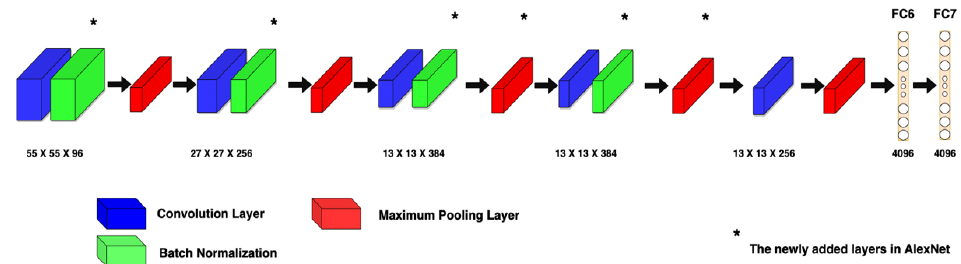
Figure 4. Mod_AlexNet: modified AlexNet architecture (4 batch normalization layers were added after the first 4 convolution layers and 2 max-pooling layers were added to the third and fourth convolution layers).